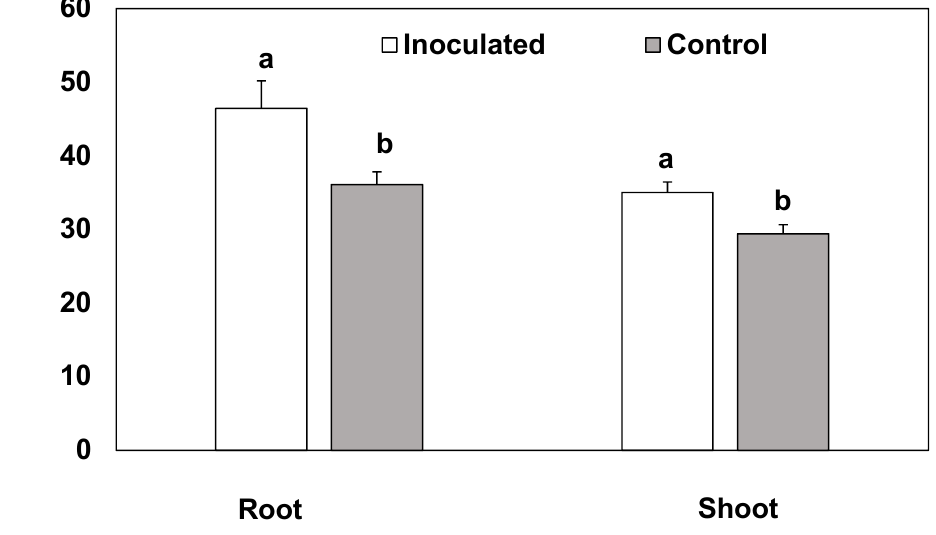
Figure 2. Root and shoot lengths of inoculated and control Douglas-fir seedlings at harvest. Data are the mean of 12 replicates. Error bars show the standard deviation. Means designated with different letters are significantly